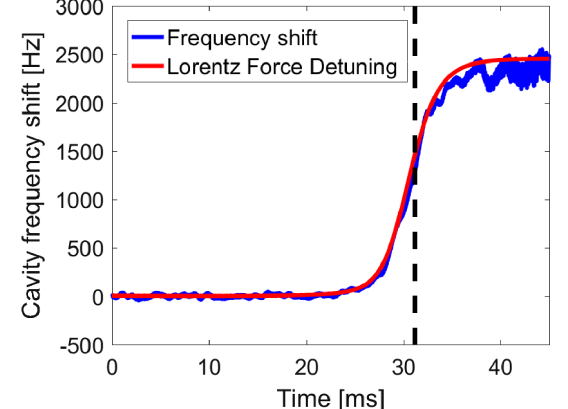
FIG. 3. Frequency shift, δ f (blue), and calculated Lorentz cav force detuning (red) vs time in the DQW PoP crab cavity during a quench measurement at SM18, CERN.